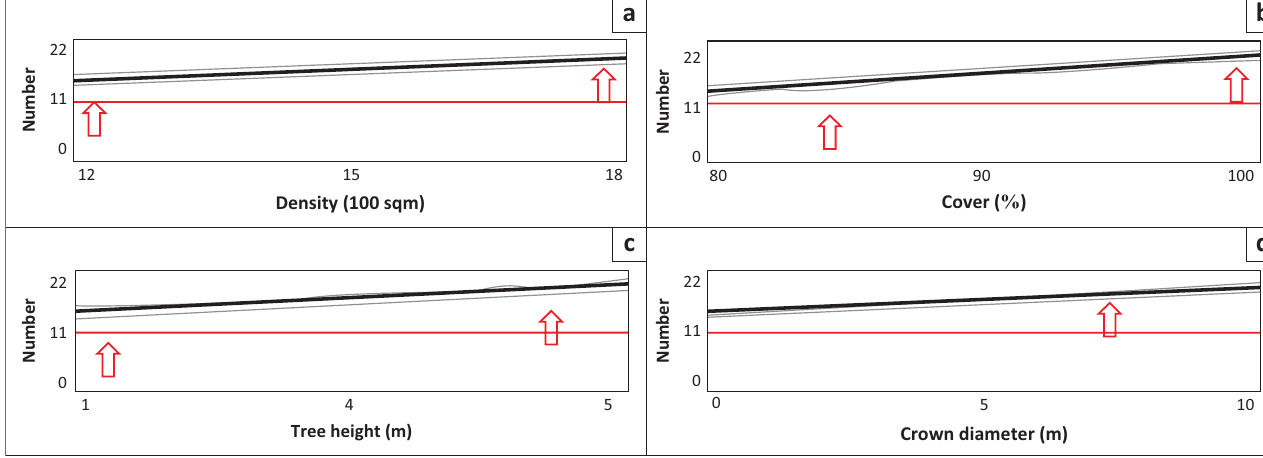
Figure 5 continues on the next page →